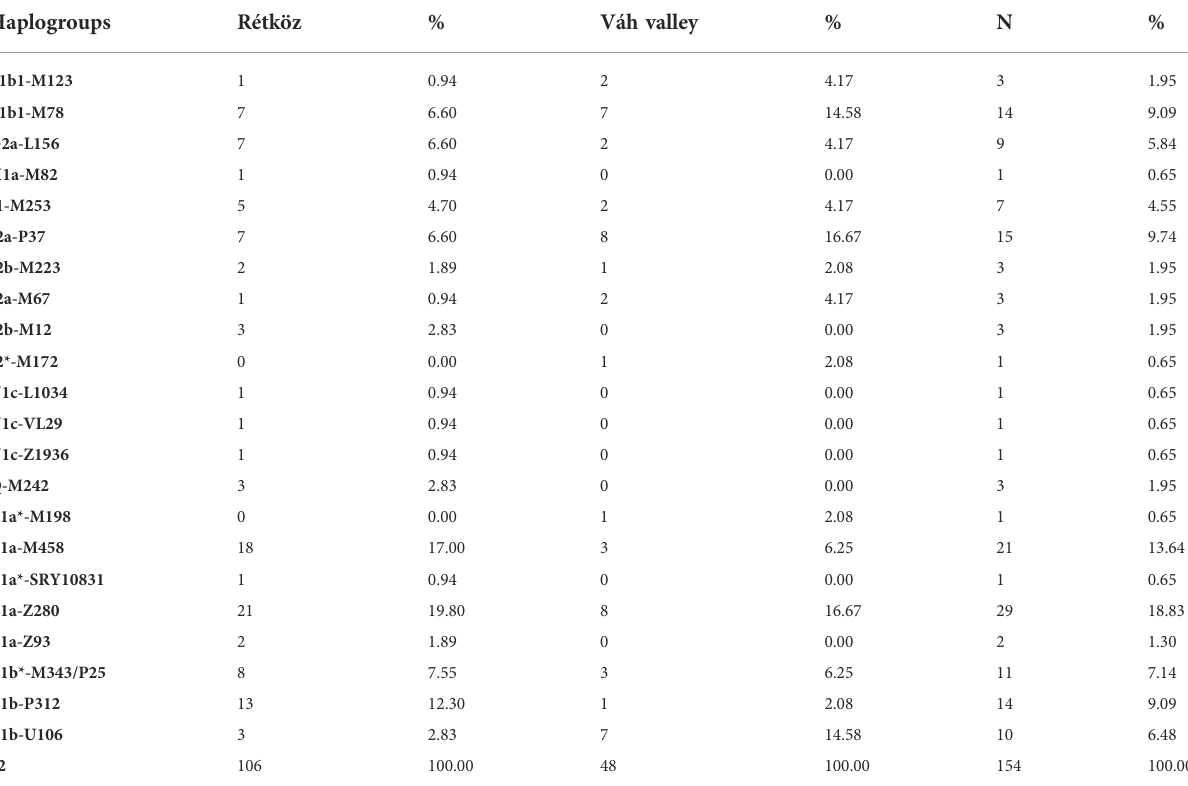
TABLE 1 Haplogroup frequencies of the Rétköz and Váh valley populatios studied.